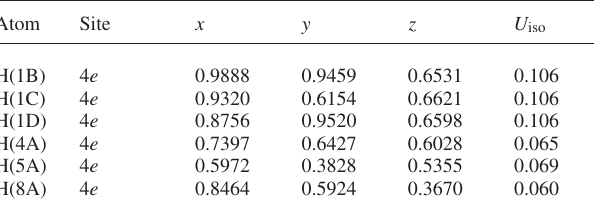
Schiffbaseshavereceivedconsiderableattentionintheliterature.